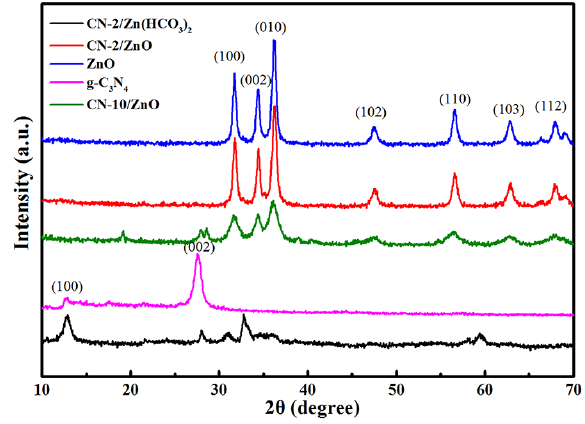
Figure 2. X-ray diffraction (XRD) patterns of ZnO, C 3 N 4 , CN-2/ZnO and CN-10/ZnO.